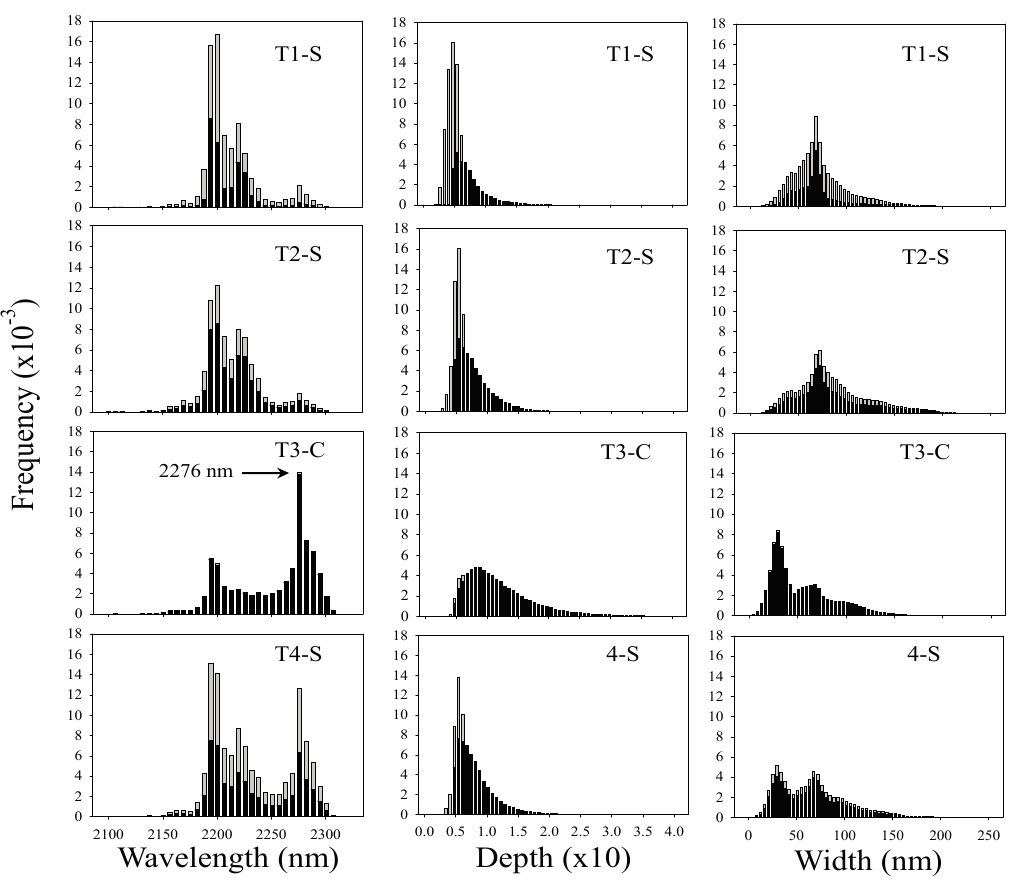
Figure 4. Histograms of feature parameters for the deepest absorption feature in the spectrum, derived from pixels in Subset 1. Black and grey bars, respectively, represent pixels whose feature parameters have been derived with or without use of a depth threshold (set at